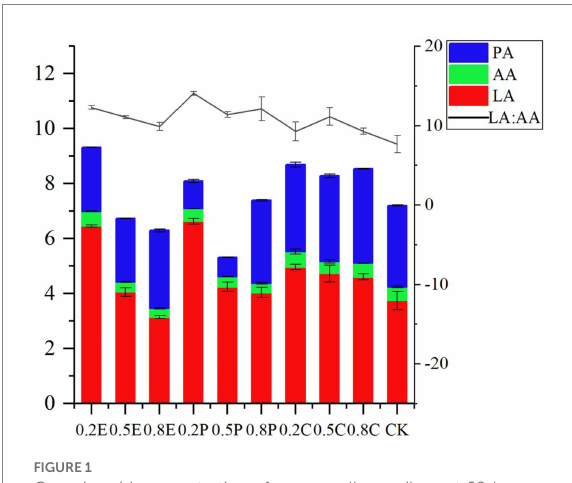
FIGURE 1 Organic acid concentration of paper mulberry silage at 60 days. CK, control; E, EDTA; P, propionic acid; C, citric acid; 0.2, concentration of additive is 2 g.kg − 1 FM; 0.5, concentration of additive is 5 g.kg − 1 FM; 0.8, concentration of additive is 8 g.kg − 1 FM; LA, lactic acid; AA, acetic acid; PA, propionic acid; LA: AA, lactate/acetic acid